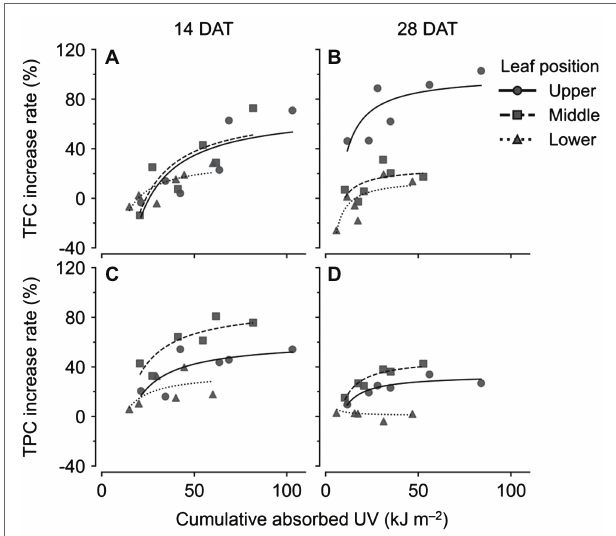
FIGURE 7 | Nonlinear regression for increase rates of compound concentrations compared to the control with cumulative absorbed UV for 3 days of kales according to leaf positions and growth stages; total flavonoid compounds (TFC; A,B ) and total phenolic compounds (TPC; C,D ) at 14 (A,C) and 28 (B,D) days after transplanting (DATs). The cumulative absorbed UV means the integration of UV irradiation absorbed by each leaf for 3 days. Refer to Eq. 2 for the nonlinear regression equation, and Table 1 for R 2 of the nonlinear